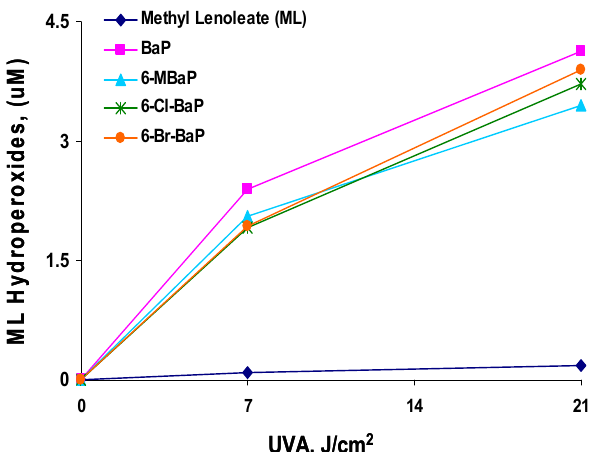
Figure 4: Peroxidation of methyl linoleate initiated by BaP, 6-MBaP, 6-Cl-BaP and 6-Br-BaP with, 0, 7, and 21 J/cm2 of UVA light. The results of 6-Cl-BaP and 6-Br-BaP are from our previously published study